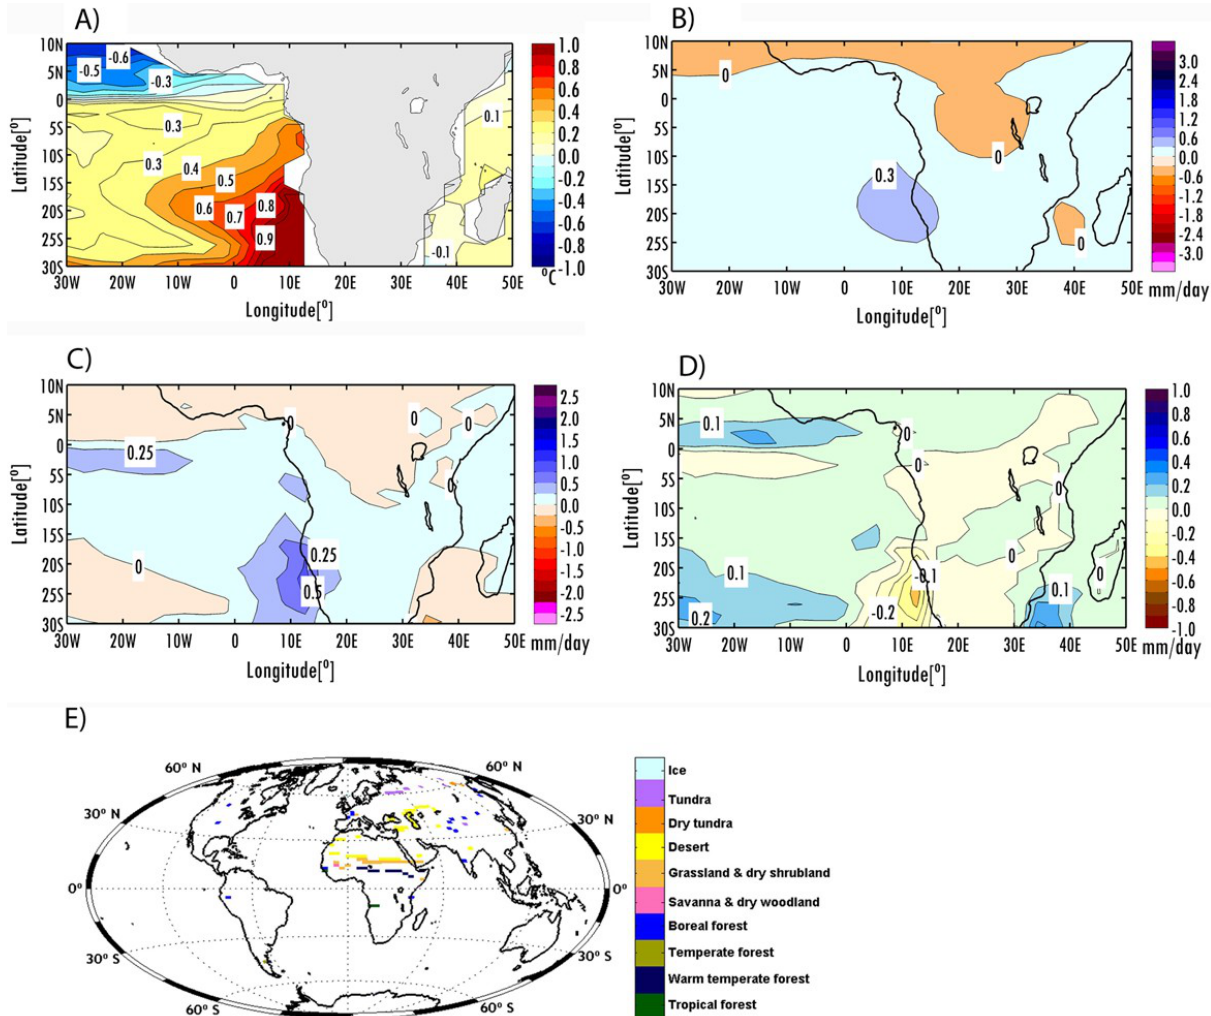
Fig. 3. Model simulations of the UVic ECSM including a dynamic vegetation component shows the anomalies between LGM and HS1 conditions. (A) Sea surface temperature in degree Celsius ( ◦ C), (B) precipitation in mm per day, (C) evaporation in mm per day, (D) net- freshwater flux (precipitation minus evaporation) in mm per day, (E) vegetation has been grouped anomaly at HS1, vegetation into mega- biomes according to Harrison and Prentice (2003). The HS1 biome of each grid cell is only plotted if it is different from the LGM